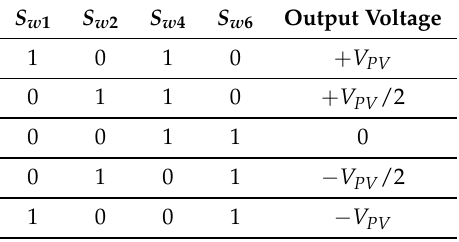
Figure 12. Five-level CMLI proposed in [111]. Table 12. Operation mode of the topology proposed in